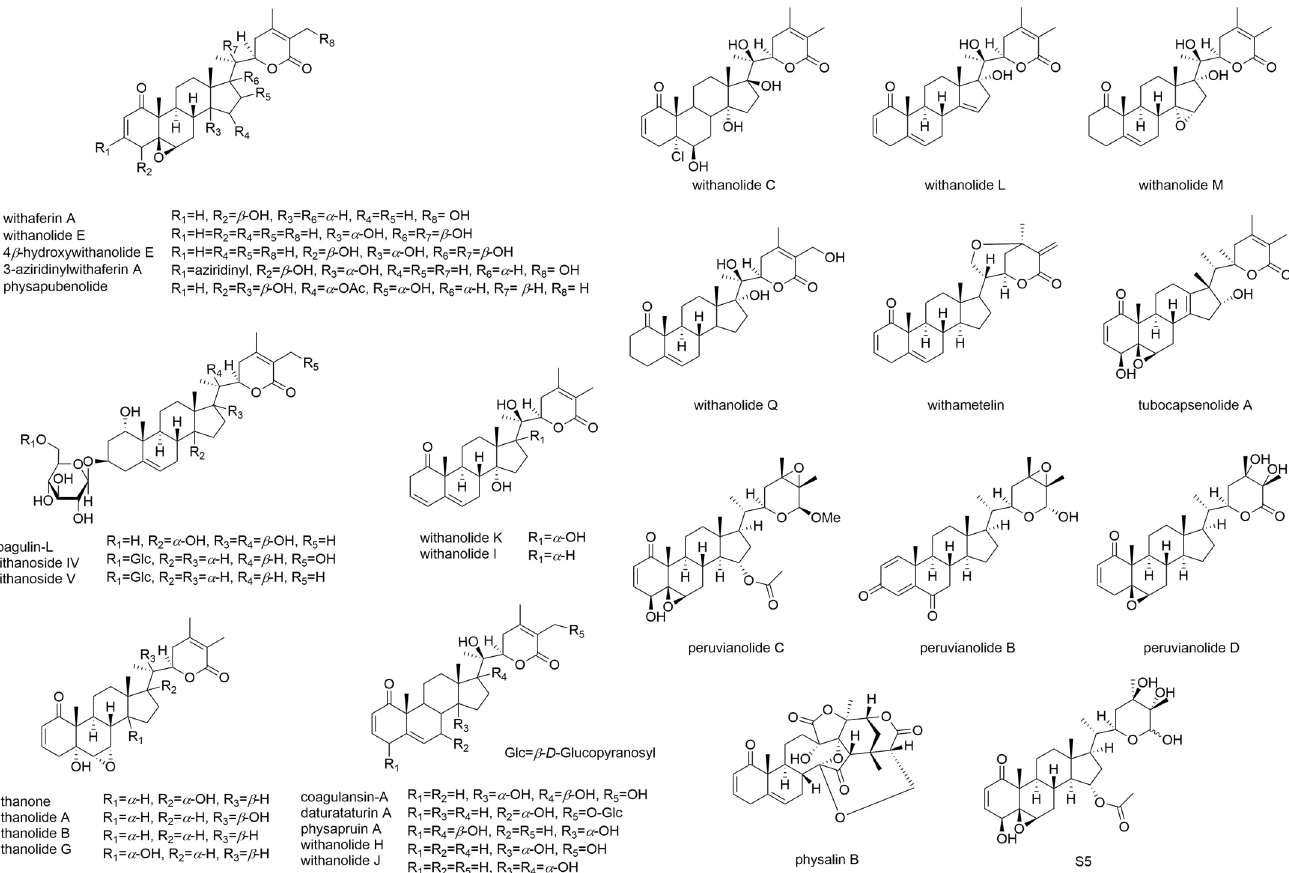
Figure 3. Structures for the selected withanolides mentioned in this review.